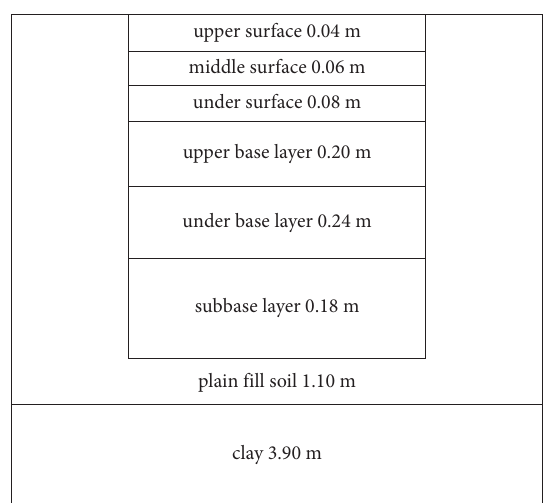
Figure 13: Schematic of pavement structure layers in the numerical model. Table 6: Parameters of pavement structure